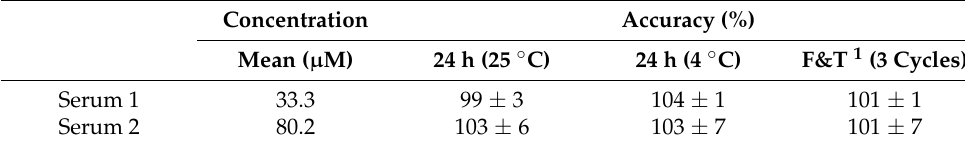
Table 3. Stability of 2HB in human serums expressed as accuracy ( n = 3).